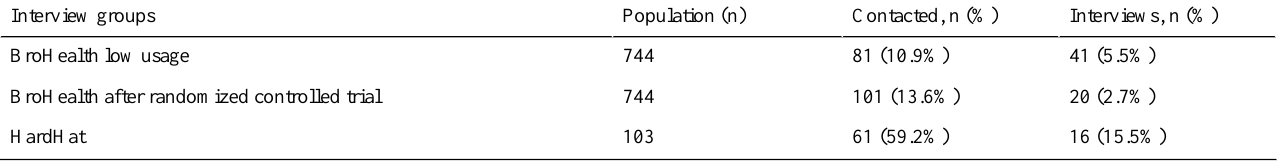
Table 1. Response rates of each group of qualitative interviews.